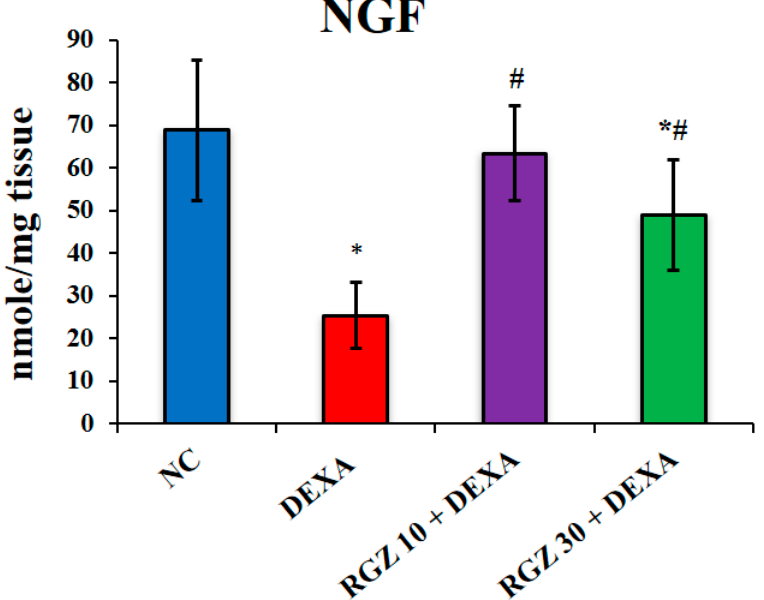
Figure 5. Effect of administration of DEXA, 20 mg/kg; s.c., RGZ, 10 mg/kg or 30 mg/kg p.o, on cere- bral NGF in mice. The statistical evaluation was conducted by a one-way ANOVA and then Tukey`s post hoc test Values are represented by the mean ± SD ( n = 8). NC—normal control; DEXA—dexa- methasone; RGZ—rosiglitazone; NGF—nerve growth factor. A significant difference was consid- ered at p < 0.05 and distinguished by * vs. NC; # vs. DEXA.